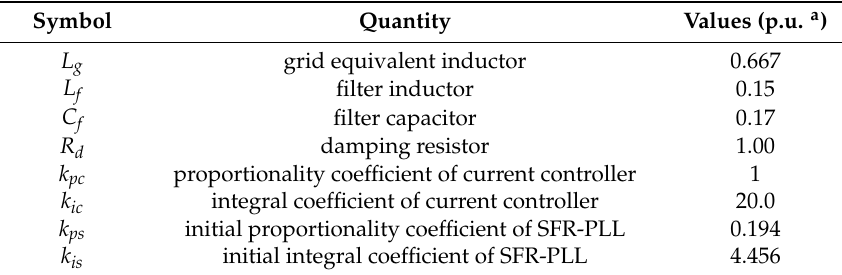
Table 1. Studied System